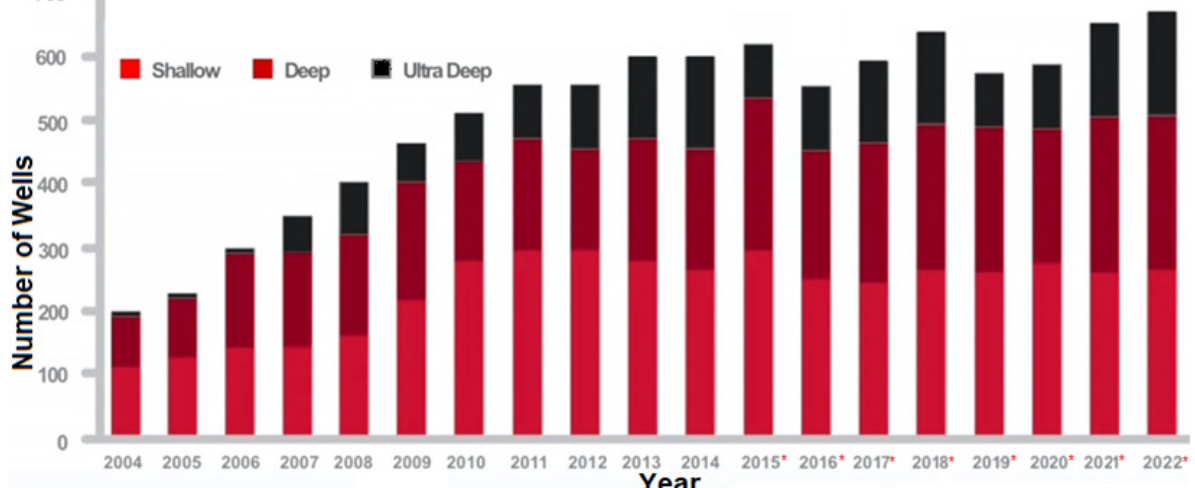
Figure 6. Number of wells drilled over time from 2004–2021, with forecast for 2015*–2022* using data from Statoil (Image Courtesy: Author 1-C.V.A.) .